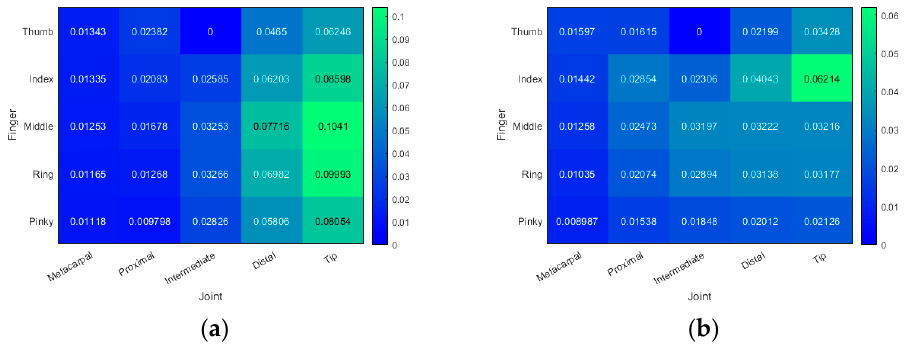
Figure 3. Degree of change with respect to each joint information according to grab and pinch gestures: ( a ) grab; ( b ) pinch.